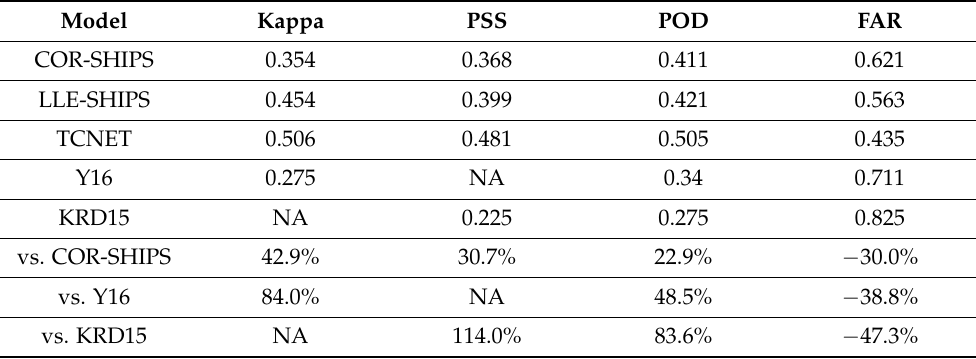
Table 5. Performance metric values for the COR-SHIPS, LLE-SHIPS, TCNET, Y16 and KRD15 models and the comparisons of TCNET model developed in this study vs. the baseline model, COR-SHIPS, Y16 and KRD15 represented by the